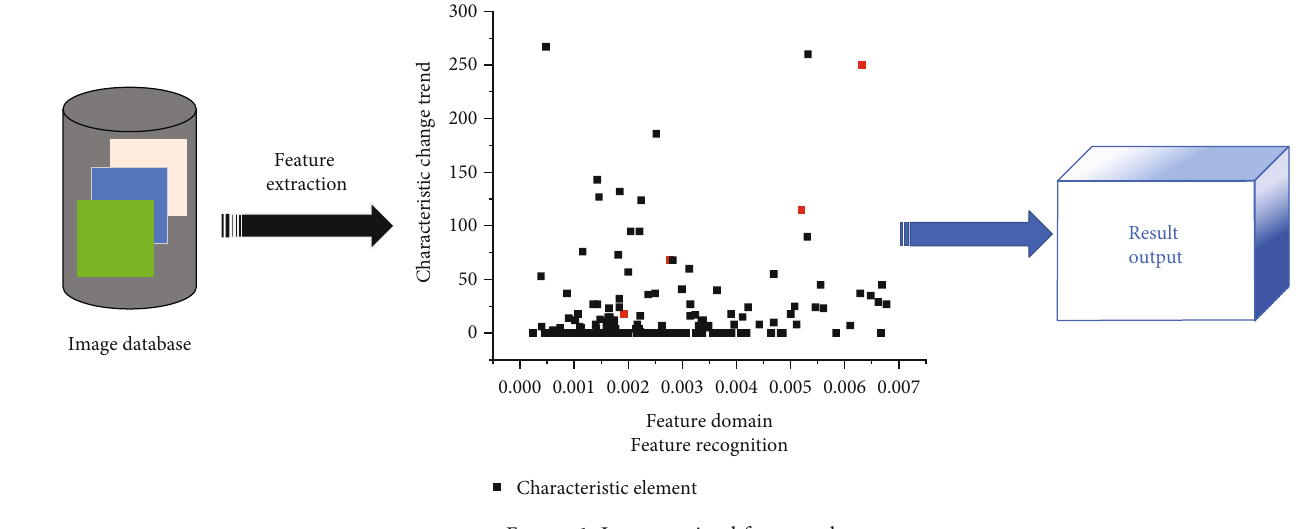
Figure 1: Image retrieval